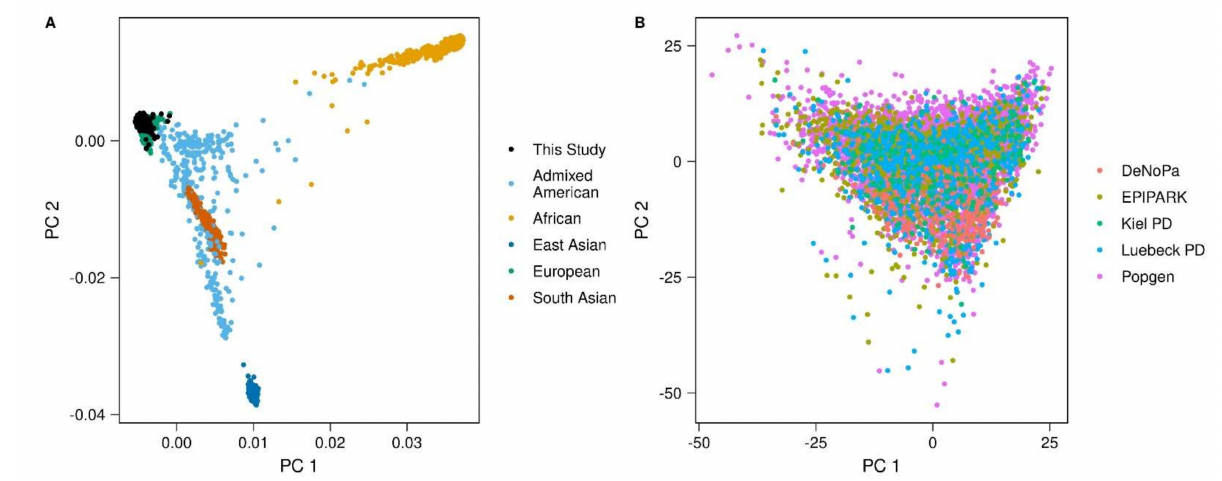
Figure A2. PCA plots after quality control. ( A ) Plot of the first two PCs from the 1000Genomes supra populations and the samples of this study. Our study samples were plotted on top, therefore obscuring part of the European samples from the 1000Genomes project. ( B ) Plot of the first two PCs from the cohorts included in our study (Table A1). PC: principal component, PCA: principal component